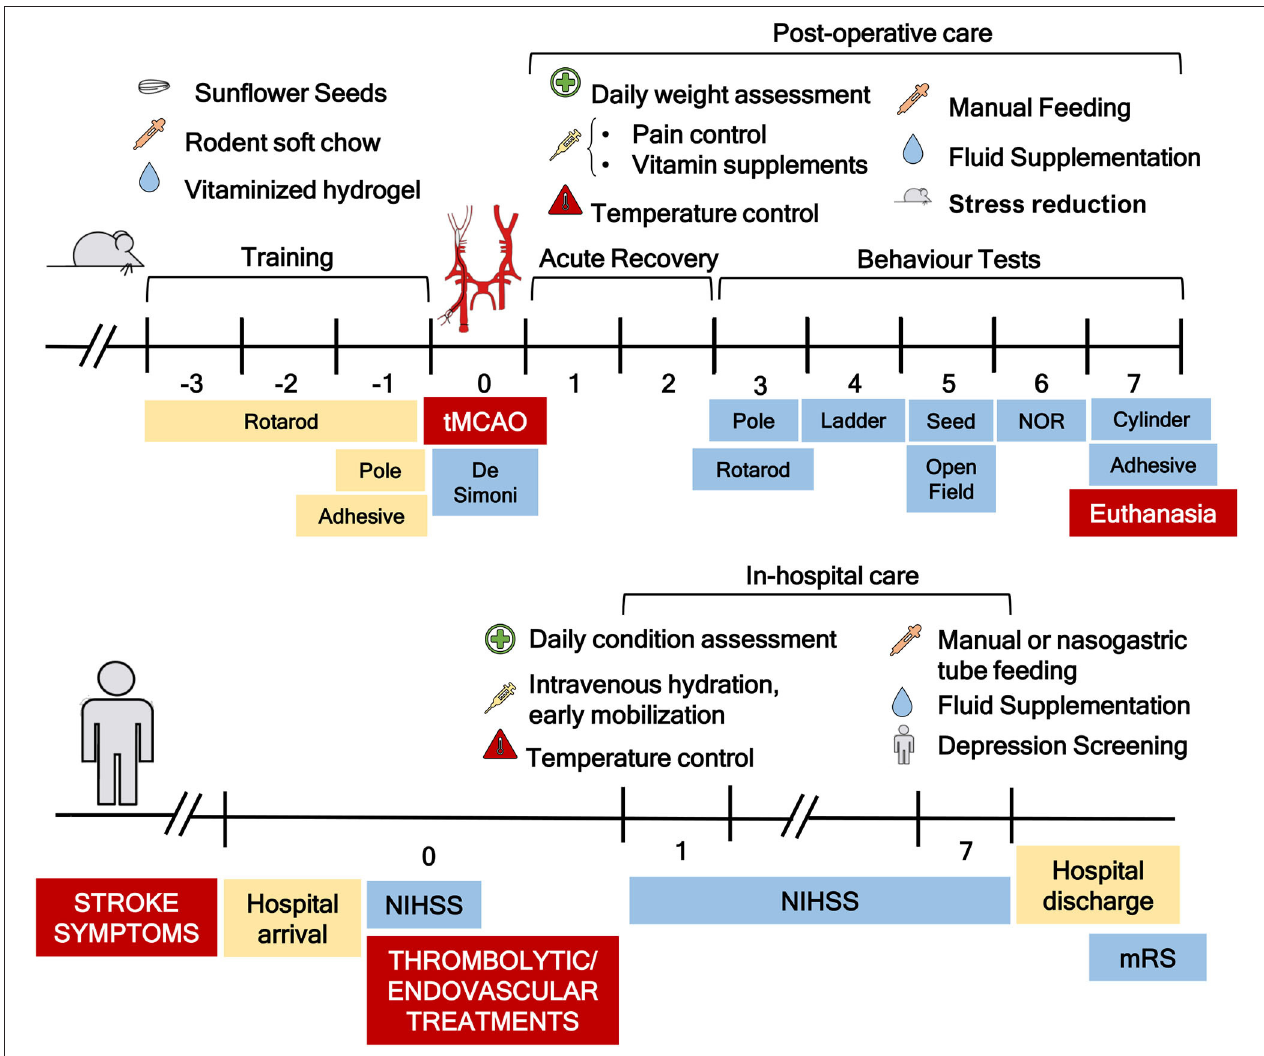
FIGURE 1 | Schematic representation of the timeline, postoperative care protocol, and functional workflow optimized. Prior to transient middle cerebral artery occlusion (tMCAO) surgery, the mice were trained on the rotarod, pole, and adhesive tests. Soft rodent chow, sunflower seeds, and vitaminized hydrogel were also placed on the floor of the cage during that period to allow for habituation. On the day of surgery, DeSimoni neurologic score was used to confirm ischemia induction and evaluate its extension. After surgery, the mice were subjected to a detailed postoperative care protocol that included pain, temperature, and stress control, manual feeding, and fluid supplementation, similar to what is applied to patients with stroke in hospital acute care. Following a period for acute recovery of 2 days, the mice were subjected to the schematized functional workflow. In the bottom part of the figure, Stroke patients therapeutic workflow is represented. A clear similarity between mice and patients can be